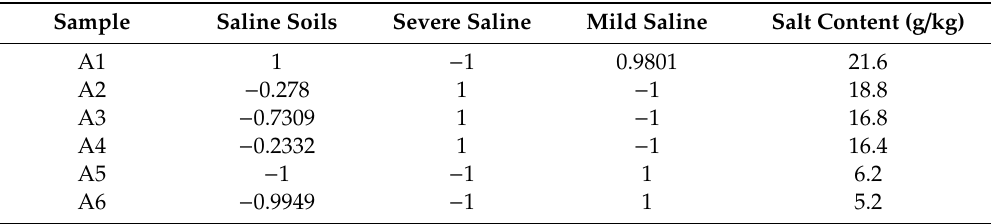
Table 3. Comparison of extension classification correlation value and salt content in Area A’s calibration set.